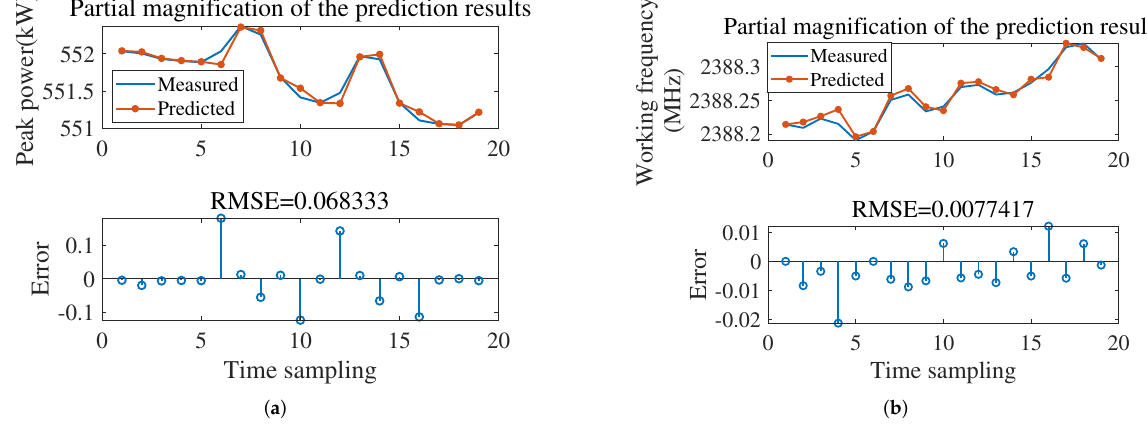
Figure 7. Partial magnification of prediction results and RMSE of the first type of degradation malfunction. ( a ) Peak power. ( b ) Working